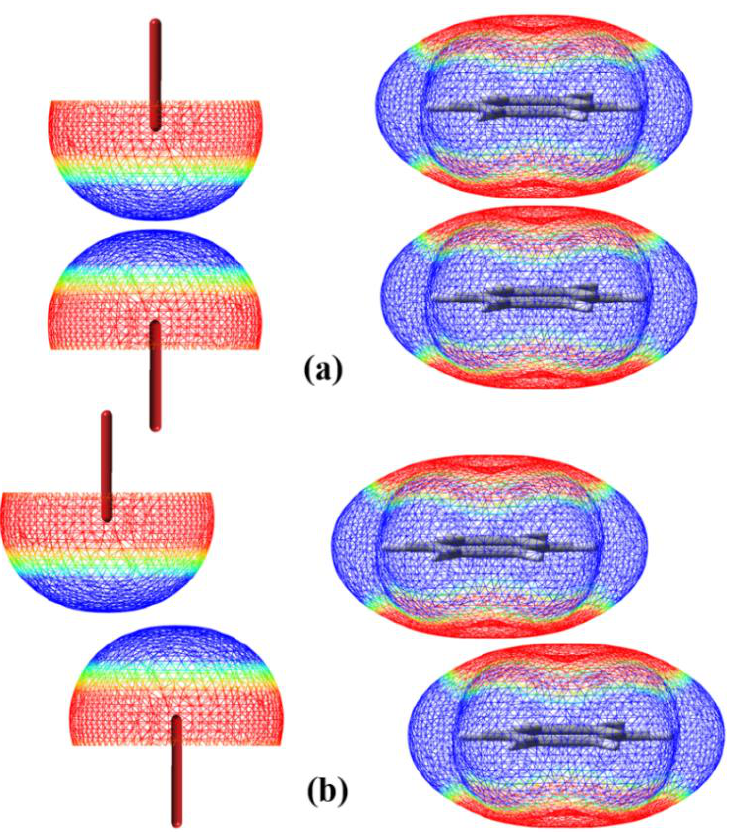
Figure 1. A schematic diagram of sandwich σ -hole ··· σ -hole stacking interaction versus sandwich π ··· π stacking interaction ( a ), and parallel-displaced σ -hole ··· σ -hole stacking interaction versus parallel-displaced π ··· π stacking interaction ( b ). The blue mesh represents the positive electrostatic potential and the red mesh represents the negative electrostatic potential.